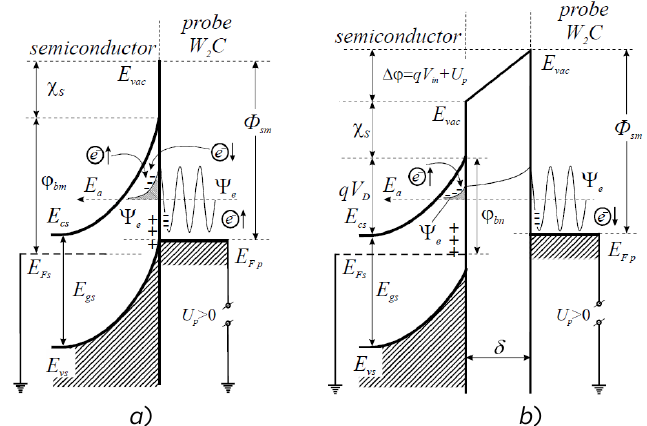
Fig. 2. The energy diagrams of the probe-semiconductor system with the grounded sample (structure) and application of positive bias U p >0: a ) to the immediate contact of the probe and semiconductor, b ) to the tunnel-transparent gap  10 nm between